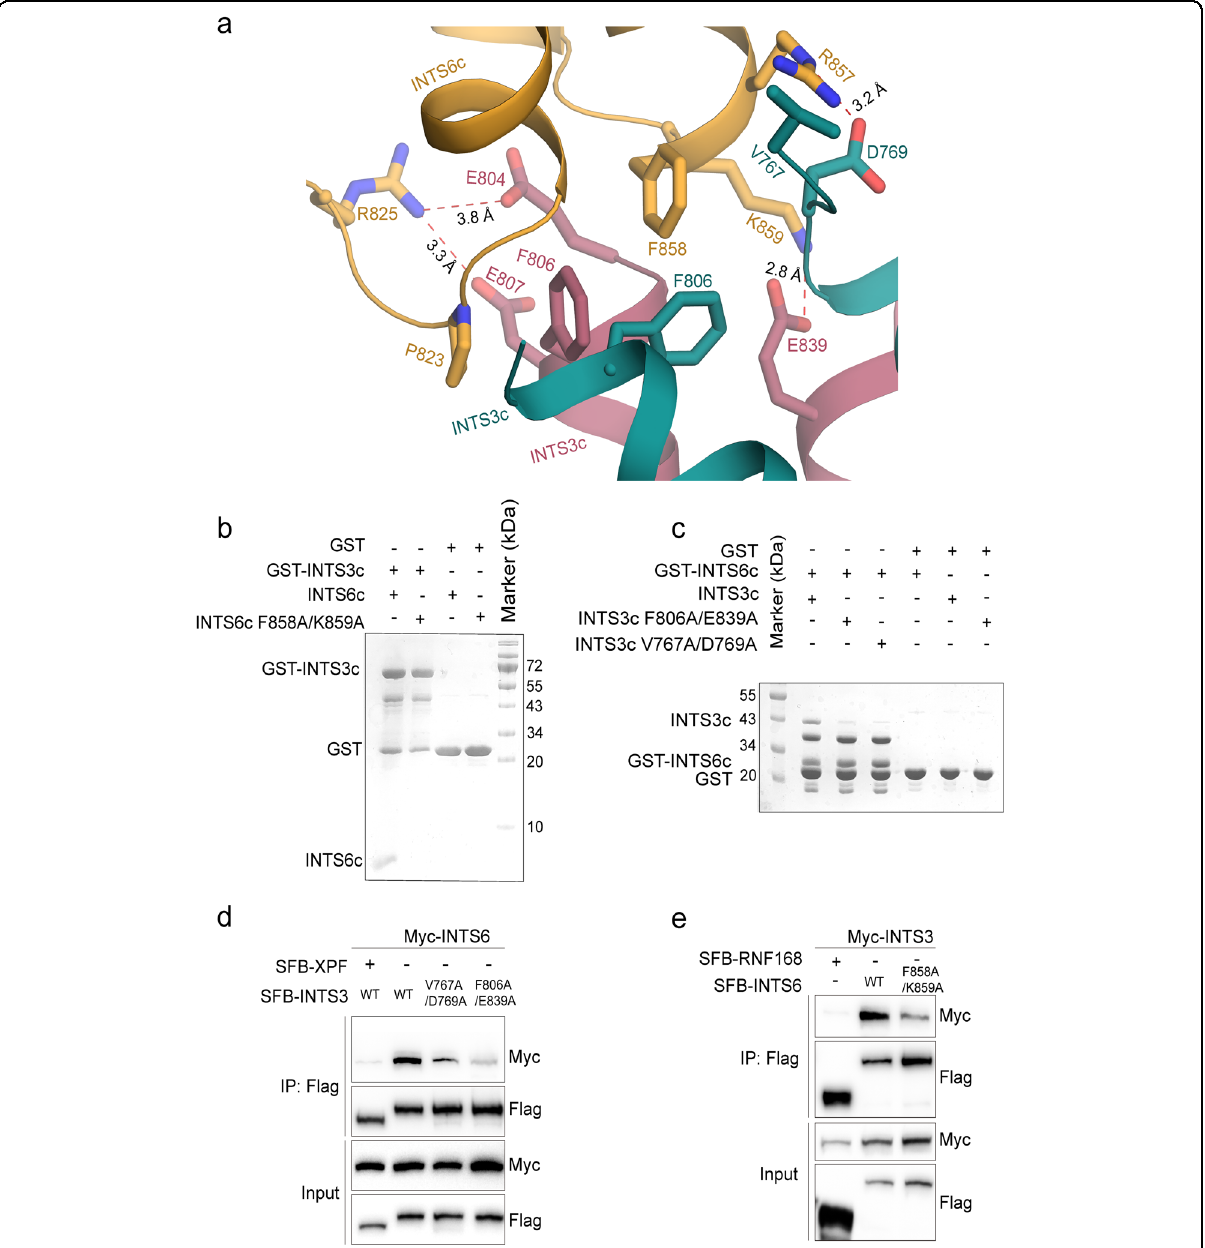
Fig. 2 Interface between INTS3c and INTS6c. a The INTS3c/INTS6c interface is composed of central hydrophobic residues, Pro823, Phe858 from INTS6c, and Phe806 from INTS3c. These hydrophobic interactions are further strengthened by salt bridges and hydrogen bonds. b GST-pull down assays show that the F858A/K839A mutant of INTS6c did not interact with INTS3c. c Results of GST-pull down assays show that the V767A/D769A and F806A/E839A mutants of INTS3c did not interact with INTS6c. d The V767A/D769A and F806A/E839A mutants of full-length INTS3 show weak interaction with full-length INTS6 in HEK293T cells that were transfected with plasmids encoding Myc-tagged INTS6 and SFB-tagged wild-type INTS3 (WT) or its mutants. SFB-tagged XPF was used as a negative control. Cell lysates were immunoprecipitated with anti-Flag antibody and western blot analysis was performed with anti-Flag and anti- Myc antibodies. e The F858A/K859A mutant of full-length INTS6 shows weak interaction with full-length INTS3. Co-immunoprecipitation experiments were performed similarly to those described in d . SFB-tagged RNF168 was used as a negative